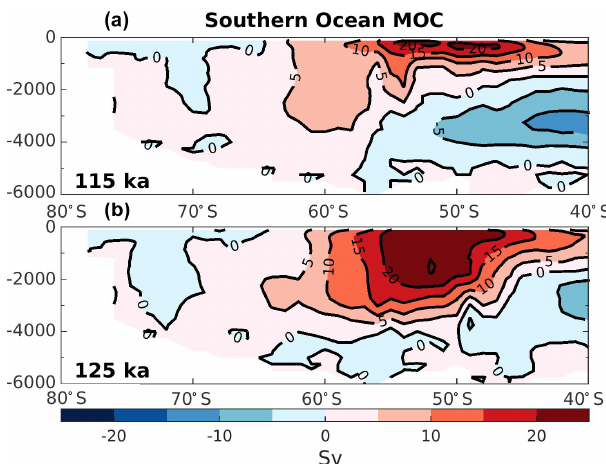
Figure 2. Southern Ocean overturning stream function in Sverdrup (Sv) for the experiment at 115ka (a) and 125ka (b) . Red colors rep- resent water masses moving clockwise, while blue colors represent water masses moving